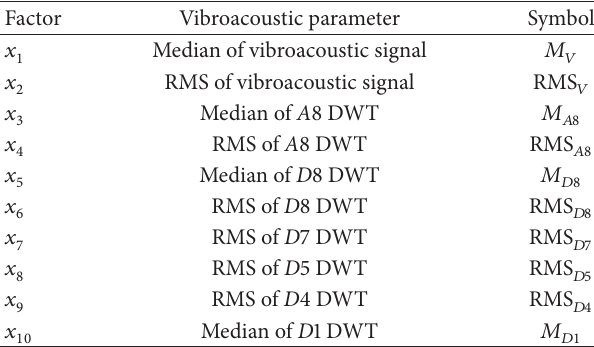
Table 2: Selected input of ANN.